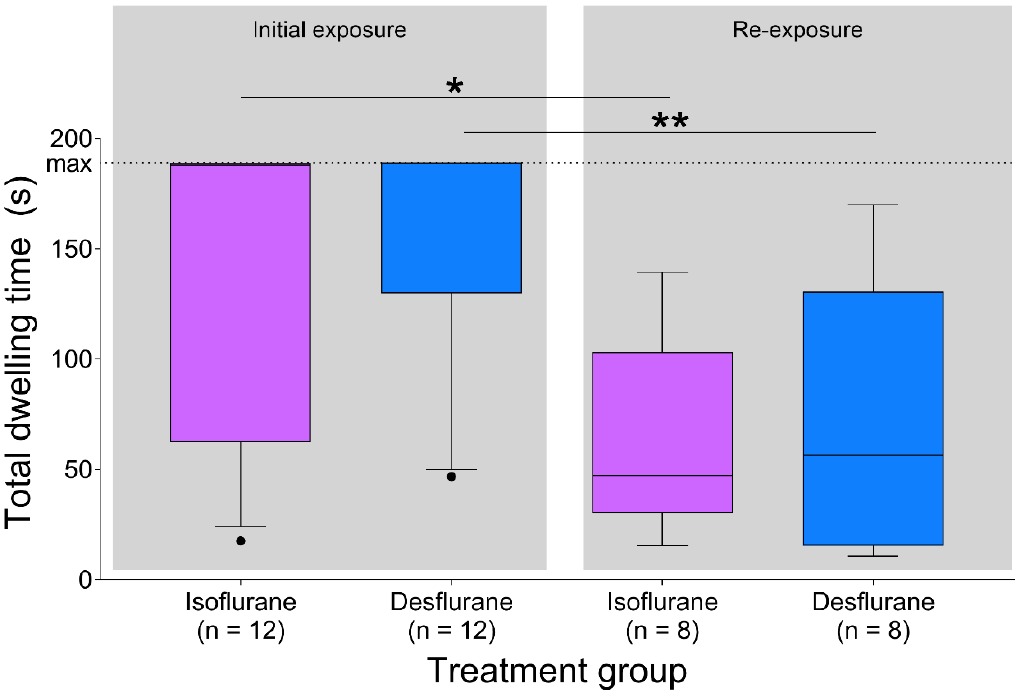
Figure 5. Total dwelling time in dark chamber (site of anesthetic gas exposure) was longer during initial exposure to both desflurane ( p < 0.01) and isoflurane ( p < 0.05). During initial exposure and re-exposure, dwelling time was similar between anesthetics ( p > 0.05). Data are presented as median (middle line in box), IQR (box limits) and 10–90 percentile (whiskers). Horizontal dotted line indicates the maximum duration of testing (3 min). * p < 0.05, ** p < 0.01. Solid circles indicate outliers (values lying ± 1.5 × IQR).